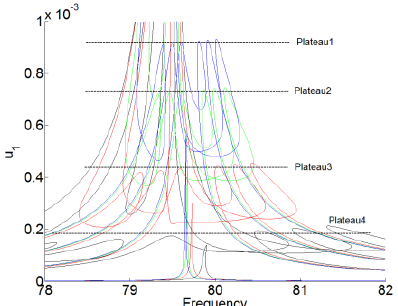
Figure 5. The plateau of the amplitude 𝑢 1 for the acoustic displacement. The forced response is under the forcing levels 𝐹 1 = [0.01: 0.6: 2] . The blue lines represent no the pre-stress, marked by ‘Plateau1′. The green lines are for 𝑓 1 = 30⁡𝐻𝑧 , marked by ‘Plateau2′. The red lines are for 𝑓 1 = 50⁡𝐻𝑧 , marked by ‘Plateau3′. The black lines are for 𝑓 1 = 65⁡𝐻𝑧 , marked by ‘Plateau4′.